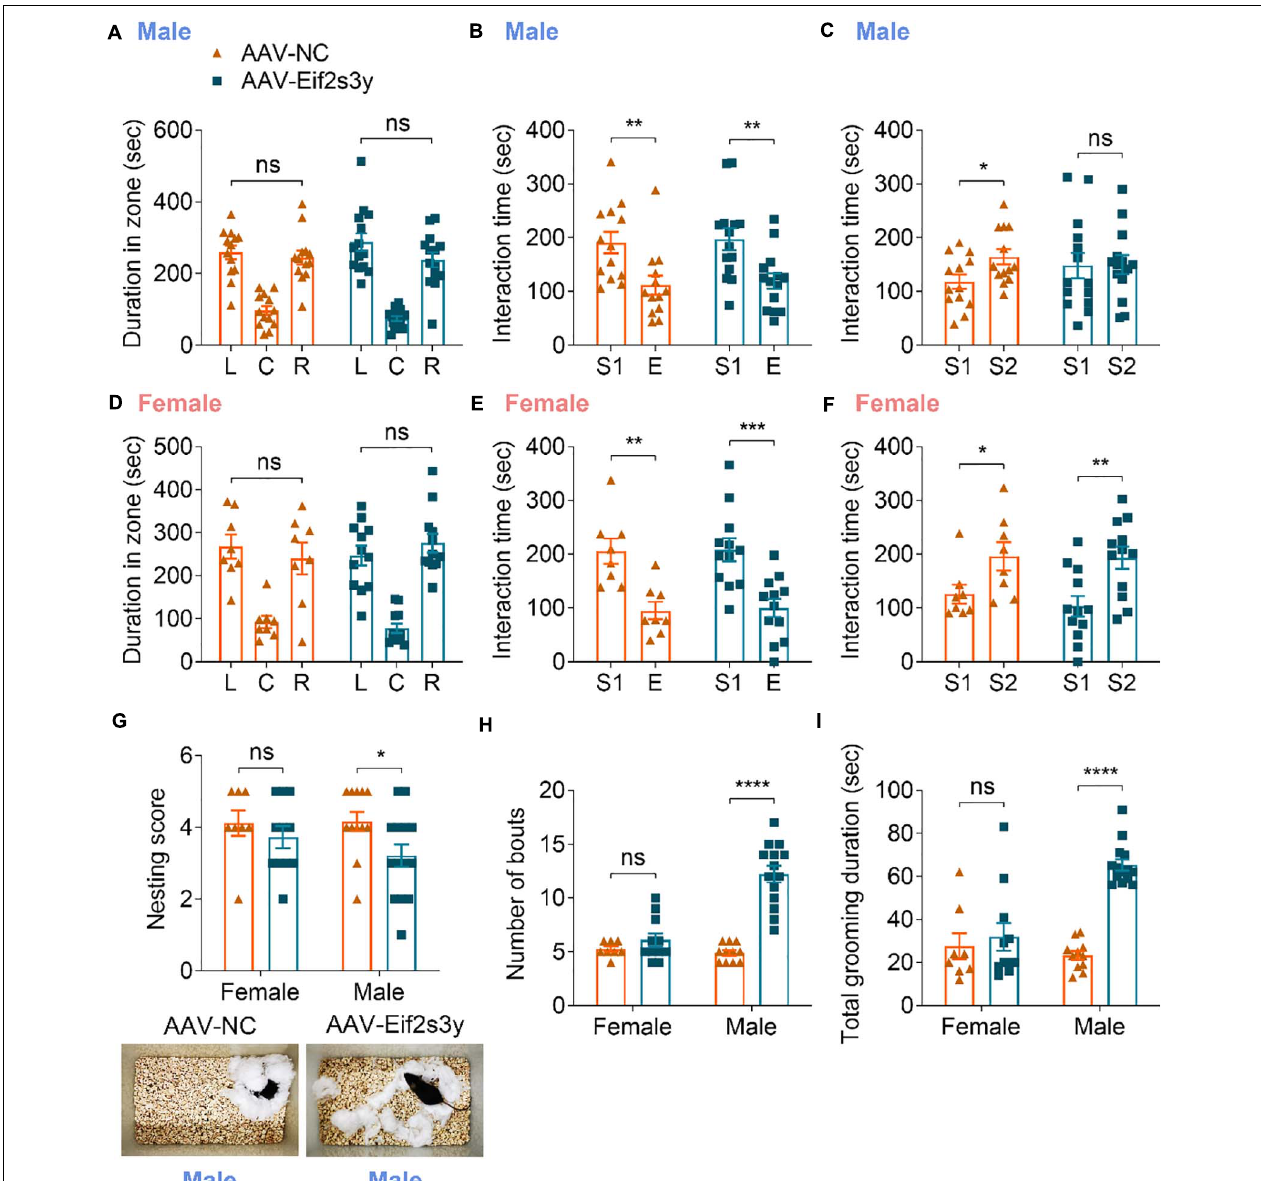
FIGURE 6 | Overexpression of Eif2s3y causes autism-like behaviors specifically in male mice. (A–F) In the three-chamber social interaction test, male mice (A–C) injected with AAV-Eif2s3y ( n = 14) or AAV-NC ( n = 13), and female mice (D–F) injected with AAV-Eif2s3y ( n = 12) or AAV-NC ( n = 8) were tested in three steps. For habituation (A,D) , mice were compared for their time spent in each empty chamber (L, left; C, center; R, right). For sociability (B,E) , mice were compared for their interaction time with an empty wire cage (E) and with a mouse (S1). For social novelty recognition (C,F) , mice were compared for their interaction time with a familiar mouse (S1) and with an unfamiliar mouse (S2). (G) Both male and female mice were compared for their nest-building ability. Representative images of nests built by male mice are shown. n = 14 AAV-Eif2s3y male mice, n = 12 AAV-NC male mice, n = 11 AAV-Eif2s3y female mice, and n = 8 AAV-NC female mice. (H,I) During free movement, mice were analyzed for bout numbers (H) and total grooming duration (I) . n = 14 AAV-Eif2s3y male mice, n = 11 AAV-NC male mice, n = 11 AAV-Eif2s3y female mice, and n = 8 AAV-NC female mice. Unpaired t-test was used for (A–F,I) . Mann Whitney test was used for (G,H) . * p < 0.05, ** p < 0.01, *** p < 0.001, **** p < 0.0001, ns, not